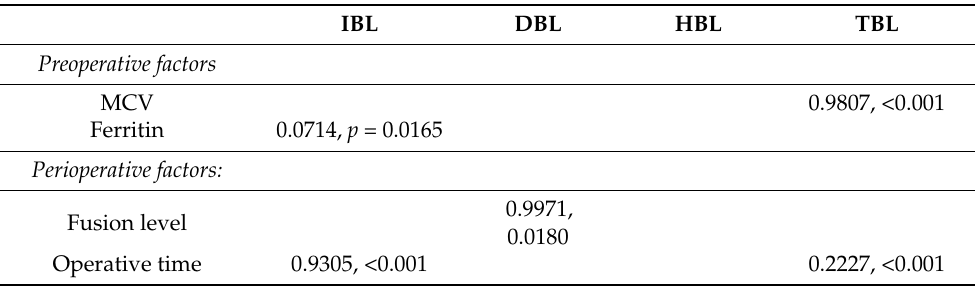
Table 4. Multiple linear regression analysis for each type of bleeding in NMS, and correlation coefficients and p -values for each factor and